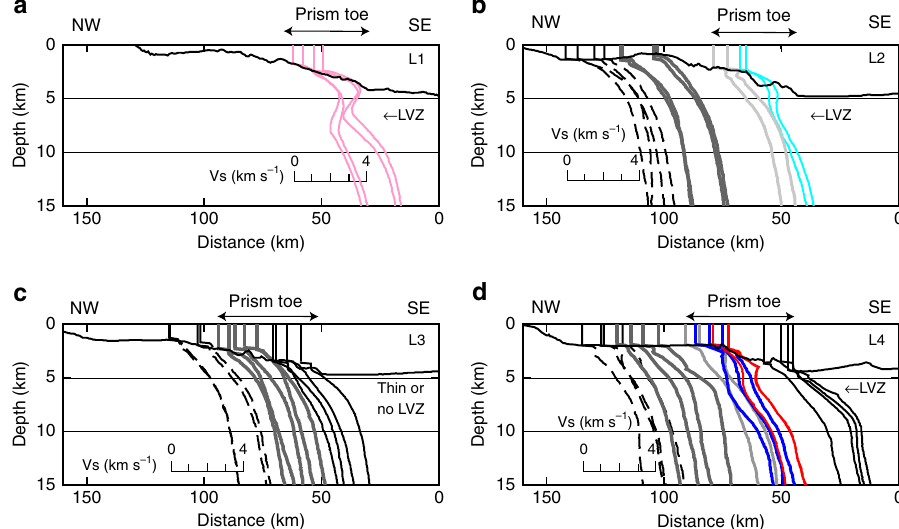
Fig. 2 Vs pro fi les for each line. Vs pro fi les for a L1, b L2, c L3, and d L4 (Fig. 1). Station locations (Fig. 1) are projected onto L1 – L4 and corresponding Vs pro fi les are plotted at the projected location. Pink, pale blue, blue, and red lines represent the LVZ feature at nodes MRG, MRF, KMB, and KMD, respectively. Black solid, dashed, and gray lines correspond to Vs pro fi les at stations belonging to the same nodes, but without the LVZ feature. Light gray lines in d correspond to Vs pro fi les at KMD16 (right) and KMB08 (left) (Supplementary Fig. 1), without the LVZ feature. Solid line at each panel indicates bathymetry along each